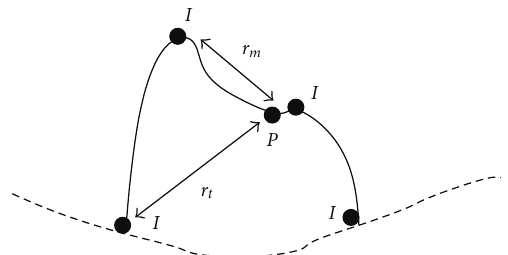
Figure 8: Model of a juxtapleural nodule with inflection points labeled as I , the distance from the origin ( P ) to the nodule periphery labeled r t , and the distance from the origin to the most distant peak labeled r m